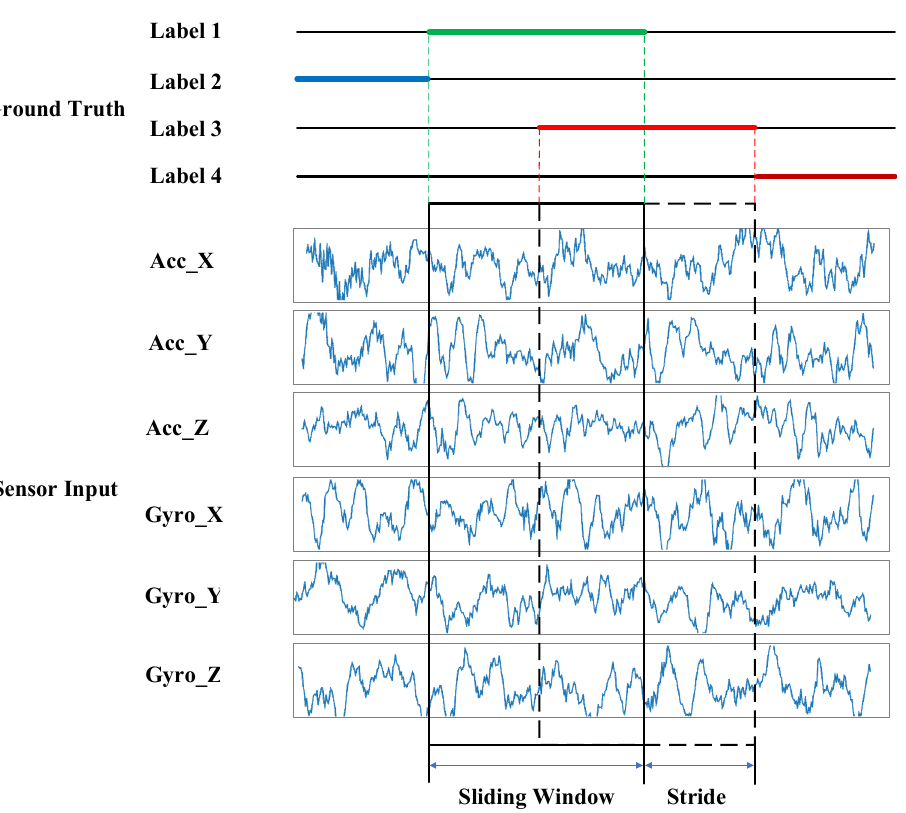
Figure 3. Schematic diagram of sliding window.